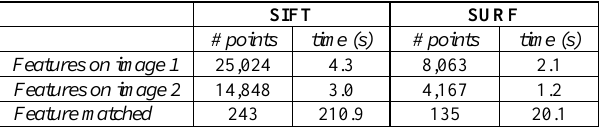
Table 2. Comparison between SIFT and SURF operators with the two intensity images in Fig. 1.